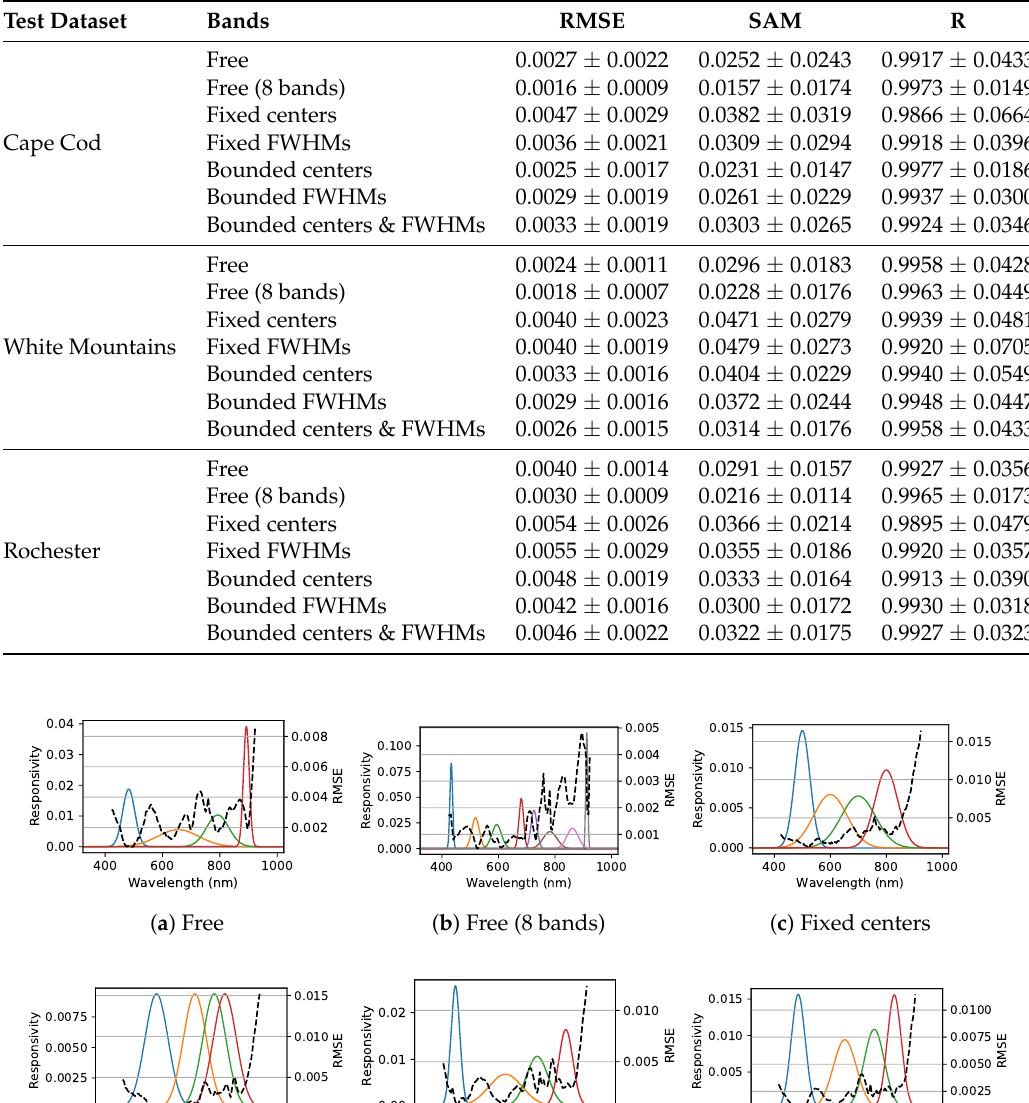
Table 3. Comparison of our model with different constraints on multispectral (MS) bands using Aerial images dataset.